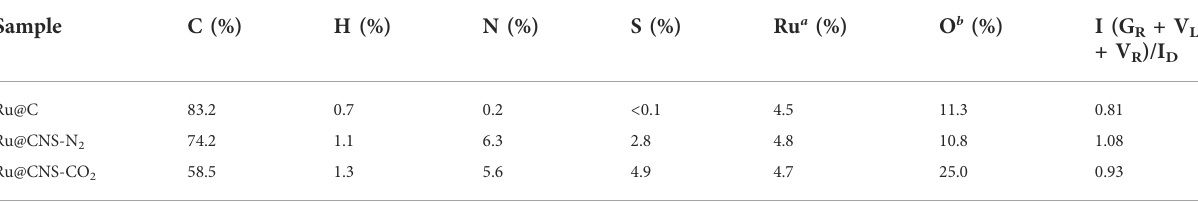
TABLE 1 Elemental and Raman analyses of the three catalysts. Sample